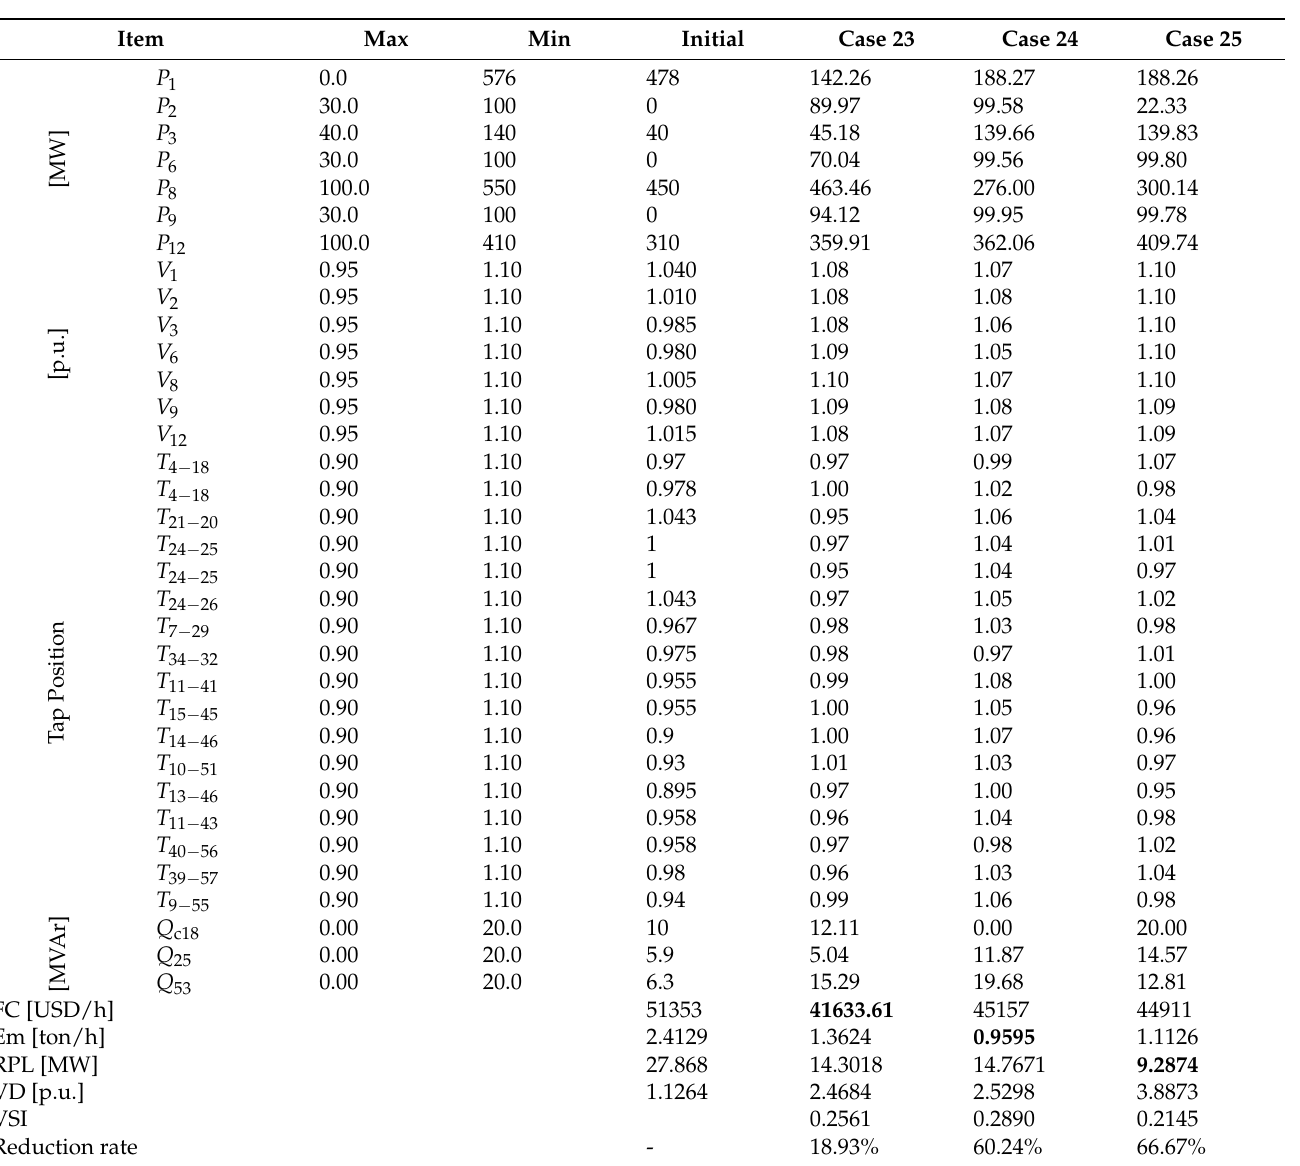
Table 8. Optimal control variables obtained by the SMA algorithm for Cases 23-25 on the IEEE 57-bus